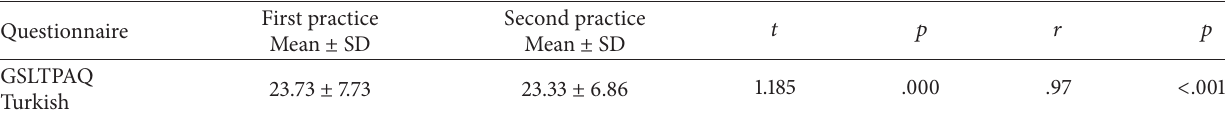
Table 2: Comparison of test-retest mean scores of the Turkish form of the Godin-Shephard Leisure-Time Physical Activity Questionnaire (GSLTPAQ) and their correlations ( 𝑛 = 30